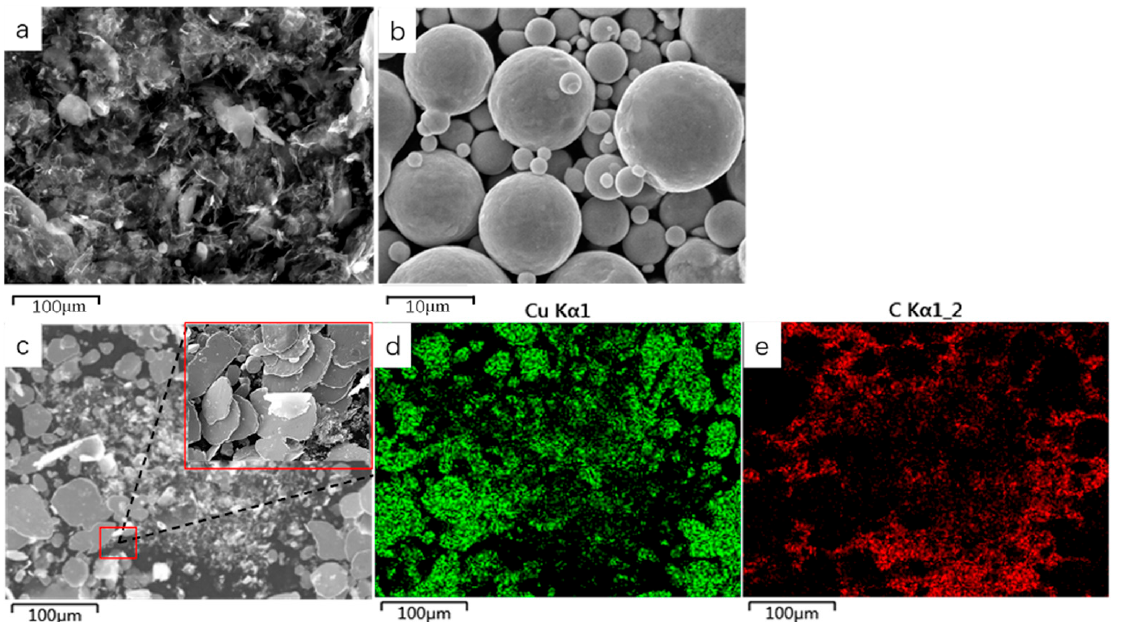
Figure 2. SEM morphological images ( a : graphene oxide; b : Cu powder; c : composite powder) and EDS elemental mapping ( d : Cu; e : C).